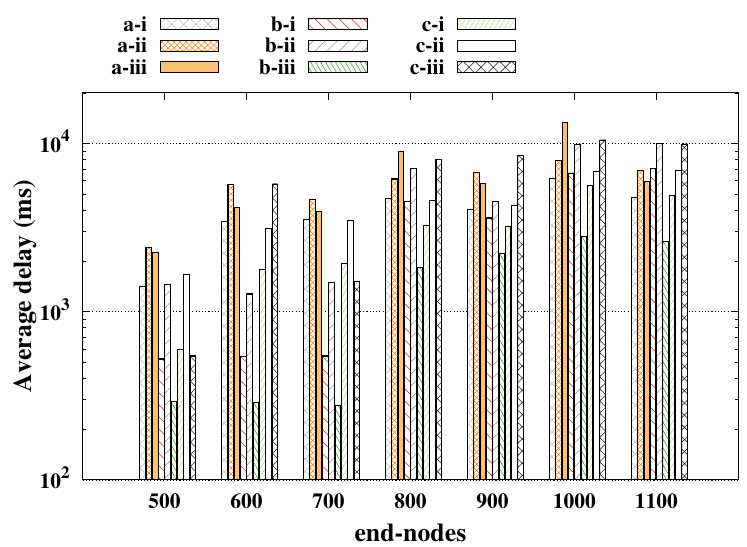
Figure 6. Alarm nodes’ delay for open field and one